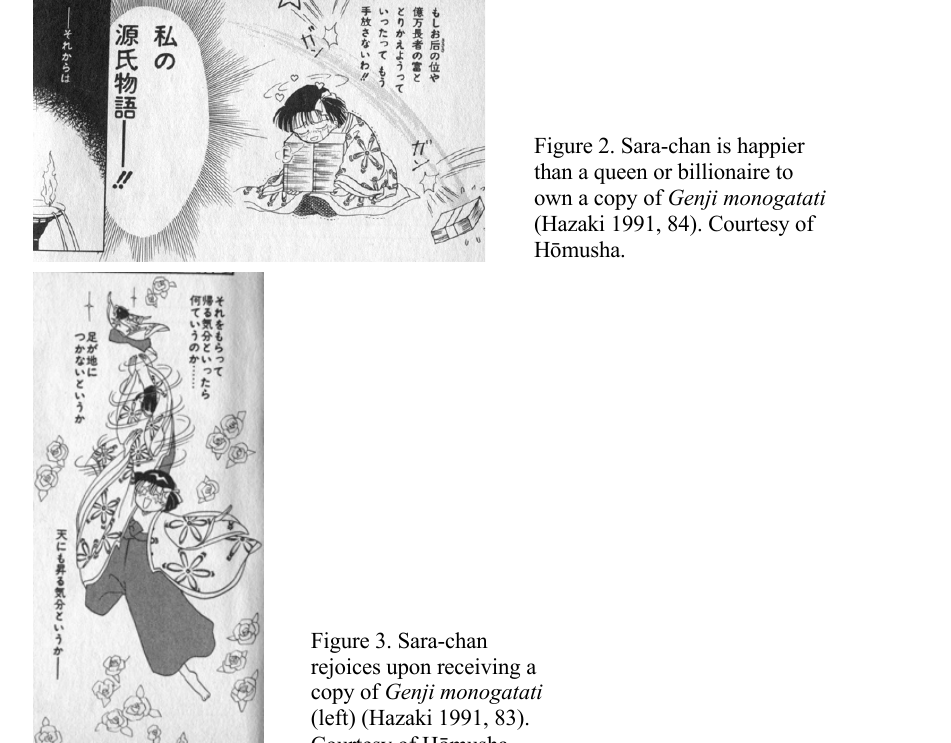
Figure 2. Sara-chan is happier than a queen or billionaire to own a copy of Genji monogatati (Hazaki 1991, 84). Courtesy of Hōmusha.